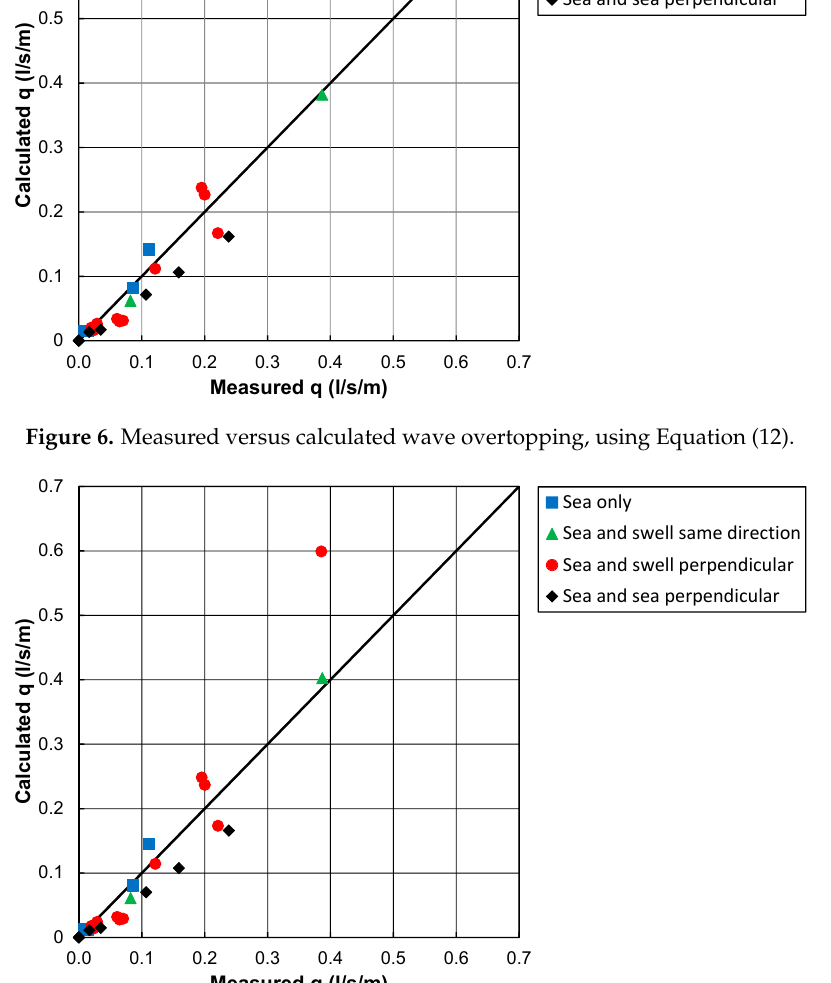
Figure 6. Measured versus calculated wave overtopping, using Equation (12).